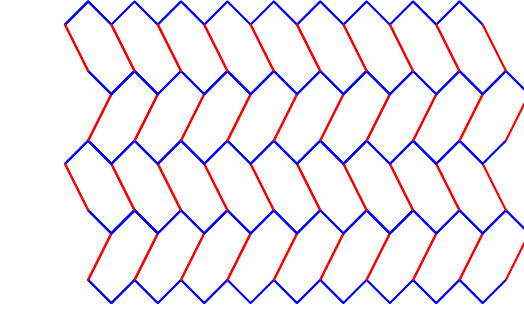
Fig. 47: Two incident edges are equal (D).